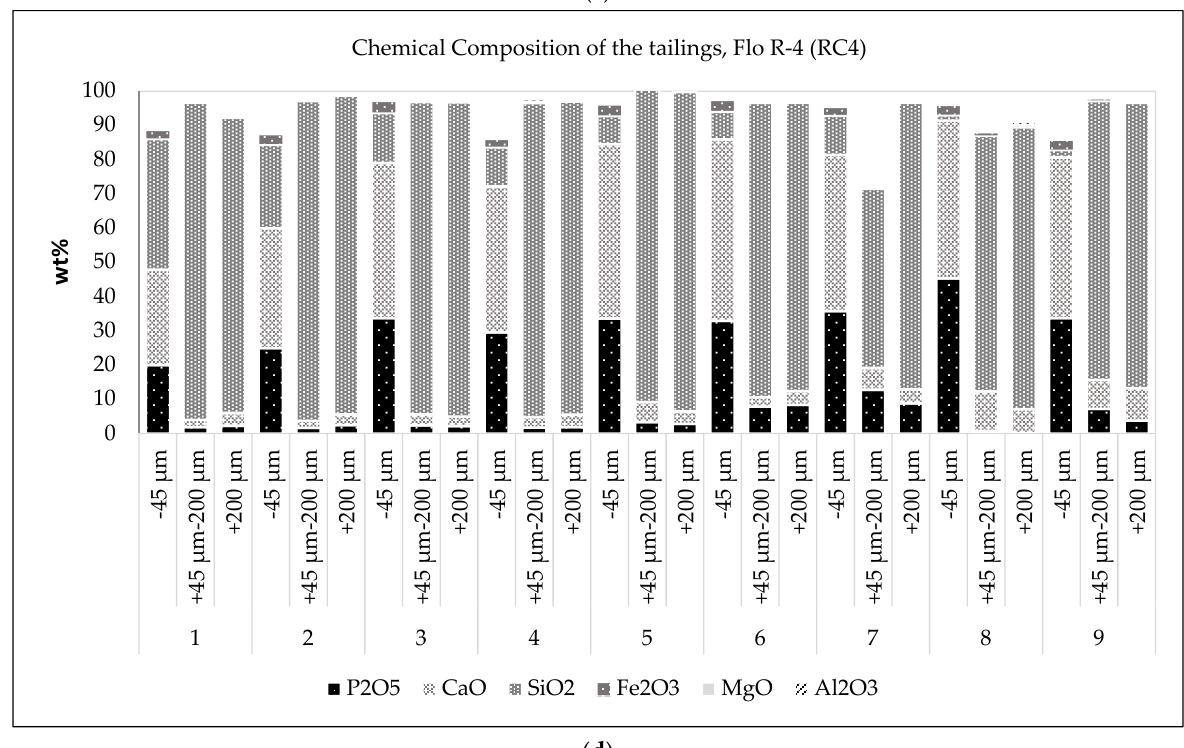
Figure 5. ( a ) Chemical composition of the tailings from the Flo R-1 (RC1) for tests 1 to 9. ( b ) Chemical composition of the tailings from the Flo R-2 (RC2) for tests 1 to 9. ( c ) Chemical composition of the tailings from the Flo R-3 (RC3) for tests 1 to 9. ( d ) Chemical composition of the tailings from the Flo R-4 (RC4) for tests 1 to 9.